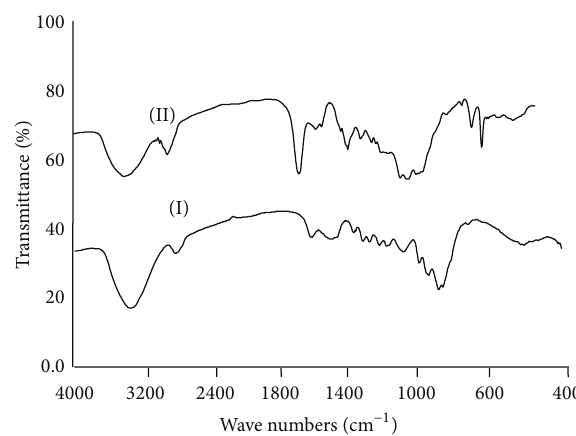
Figure 1: FTIR spectrum of (I) raw Jelutong wood and (II) treated Jelutong